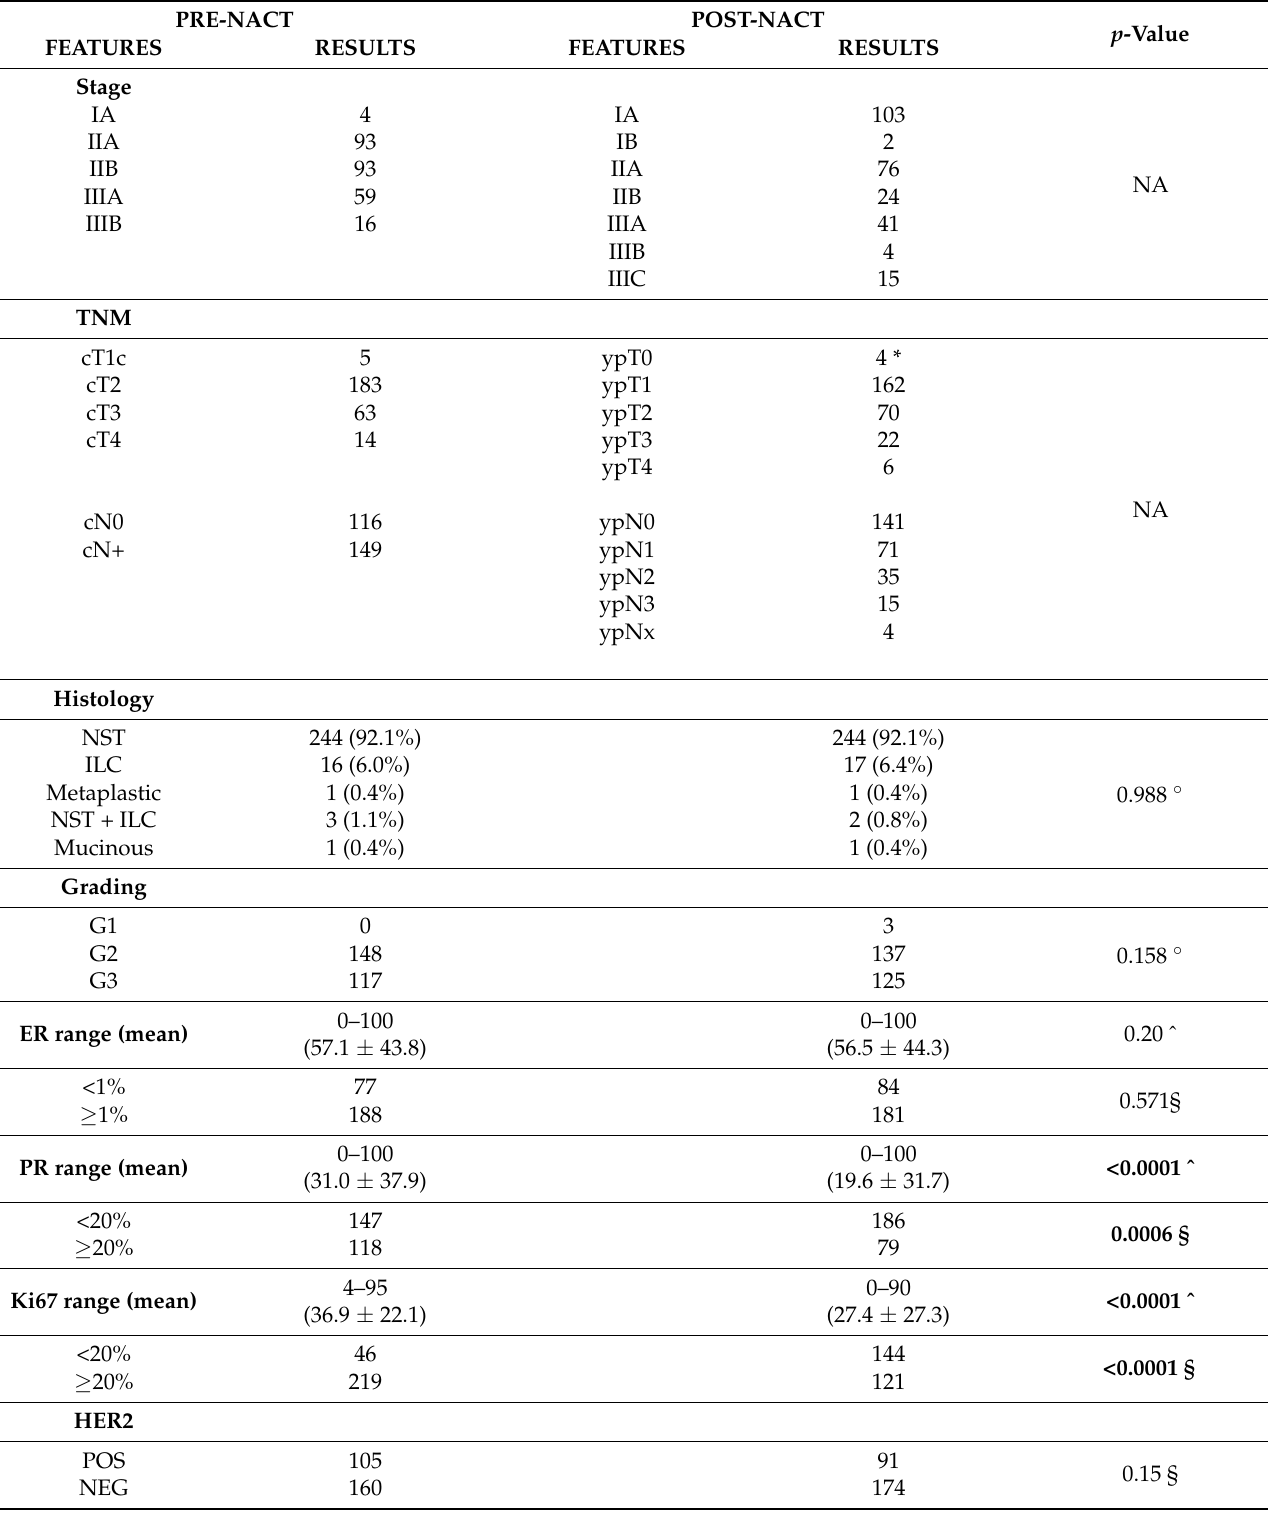
Table 1. Clinicopathological features of the cohort (265 tumors from 264 patients) pre- and post-neoadjuvant chemotherapy. PRE-NACT POST-NACT